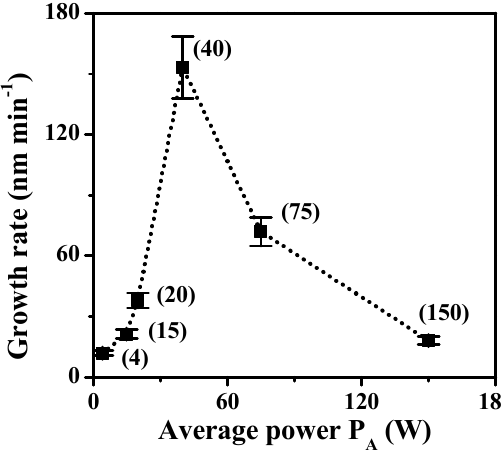
Figure 4. Growth rate of plasma polymers deposited on silicon wafer as a function of average input power ( P , given in A